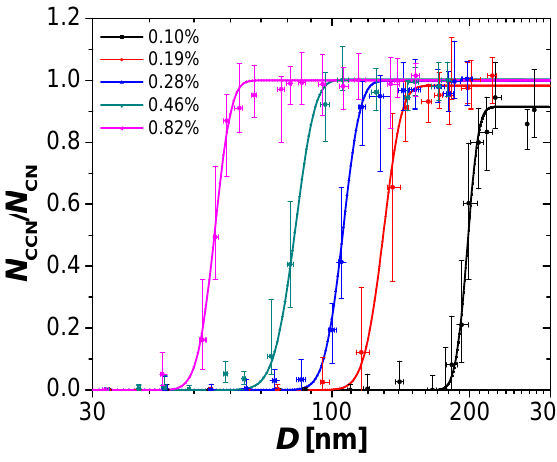
Fig. 2. Size-resolved CCN efficiency spectra at different levels of supersaturation ( S = 0.10-0.82%) averaged over the entire campaign: activated particle fraction N / N plotted against mobility equivalent diameter D . The data points are median values, the error bars extend from the lower to the upper quartiles, and the lines are 3-parameter cumulative Gaussian distribution function (CDF) fits.